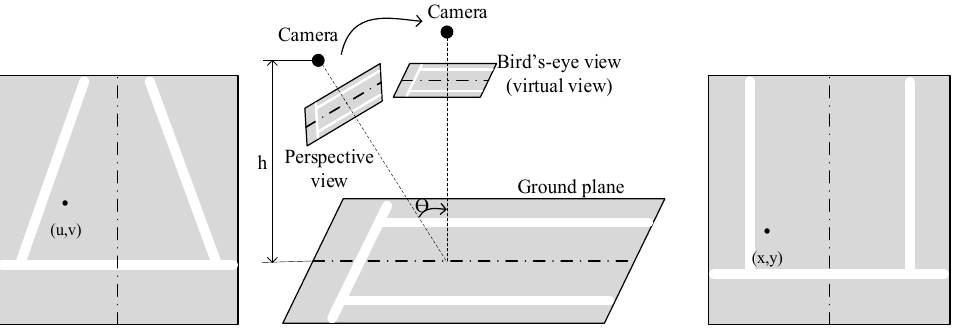
Figure 14. Demonstration of image transformation.